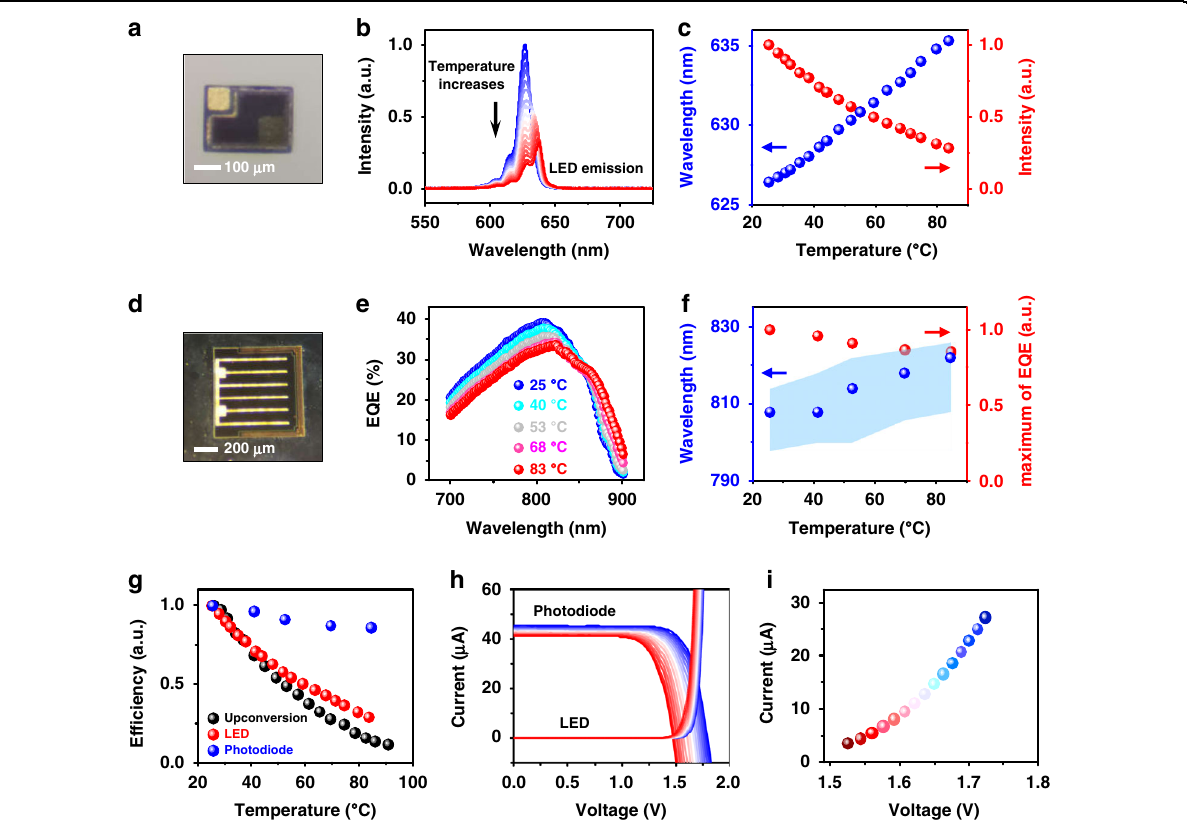
Fig. 2 Thermal behaviors of individual InGaP LED and GaAs photodiode. a Micrograph of an InGaP LED. b Electroluminescence (EL) spectra of the InGaP LED at varied temperatures (25 – 90 °C), with an injected forward current of 20 µA. c EL intensity changes (red dots) and peak wavelength shifts (blue dots) for the InGaP LED at different temperatures. d Micrograph of a double junction GaAs photodiode. e External quantum ef fi ciency (EQE) spectra of the GaAs photodiode at different temperatures. f Peak absorption intensity changes (red dot) and peak wavelength shifts (blue dot) of the GaAs photodiode at different temperatures. The shaded blue region is the wavelength range where the absorption intensity is above 98% of the peak. g Summary of ef fi ciency results, including PL of the upconversion device, EL of the LED, and EQE of the photodiode at varied temperatures (25 – 90 °C). h Current – voltage curves of the InGaP LED and the GaAs photodiode (under irradiance 40 mW cm − 2 , 810 nm) at varied temperatures from 25 °C (blue) to 90 °C (red). i Values of current and voltage at the intersection points in h , indicating the corresponding working conditions of the optoelectronic upconversion